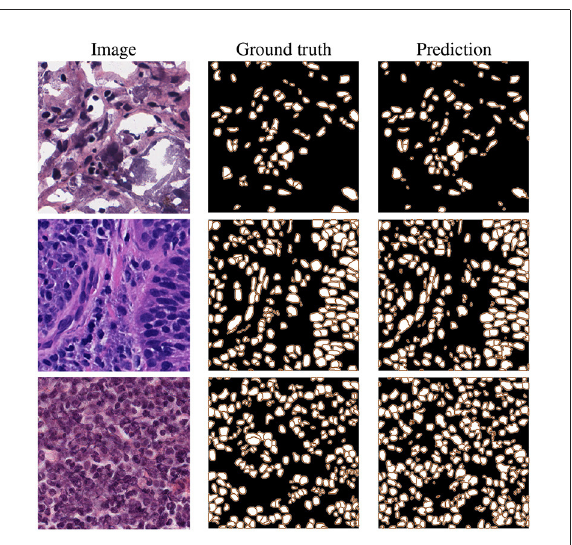
FIGURE5 Example results on CryoNuSeg test images, selected from adrenal gland (top) , larynx (middle) , and lymph node (bottom)